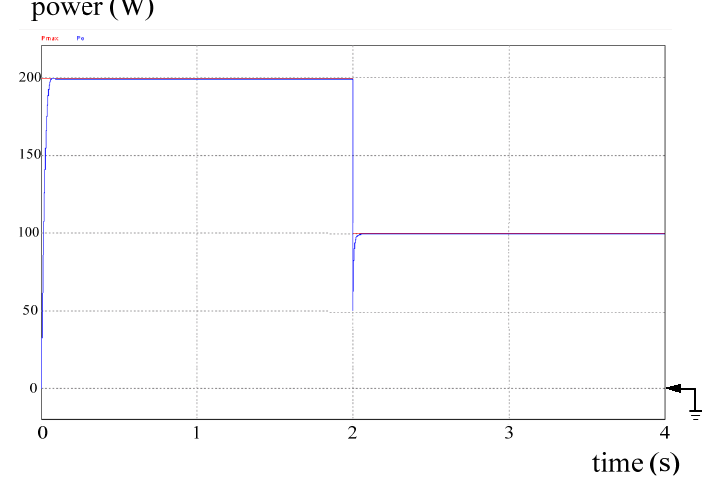
Figure 21. Simulated result: tracking trajectory of the converter with the DLAA while PV power steps down from 200 to 100 W. Note: power: 50 W/div; time: 1 s/div.